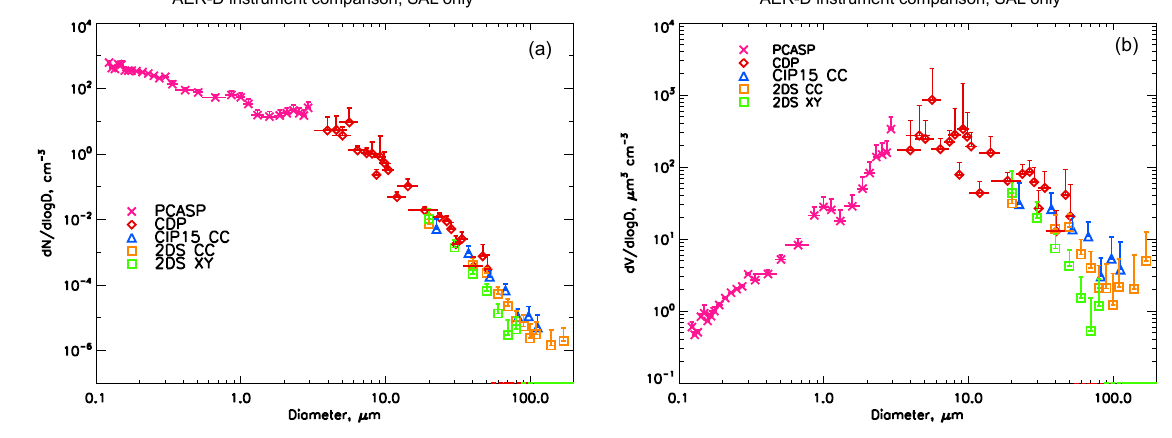
Figure 2. Comparison of mean size distributions in the SAL during AER-D from different instruments and different sizing metrics. For clarity only upper error bounds are shown. Horizontal error bars represent maximum bin width due to uncertainties in both bin centre and bin